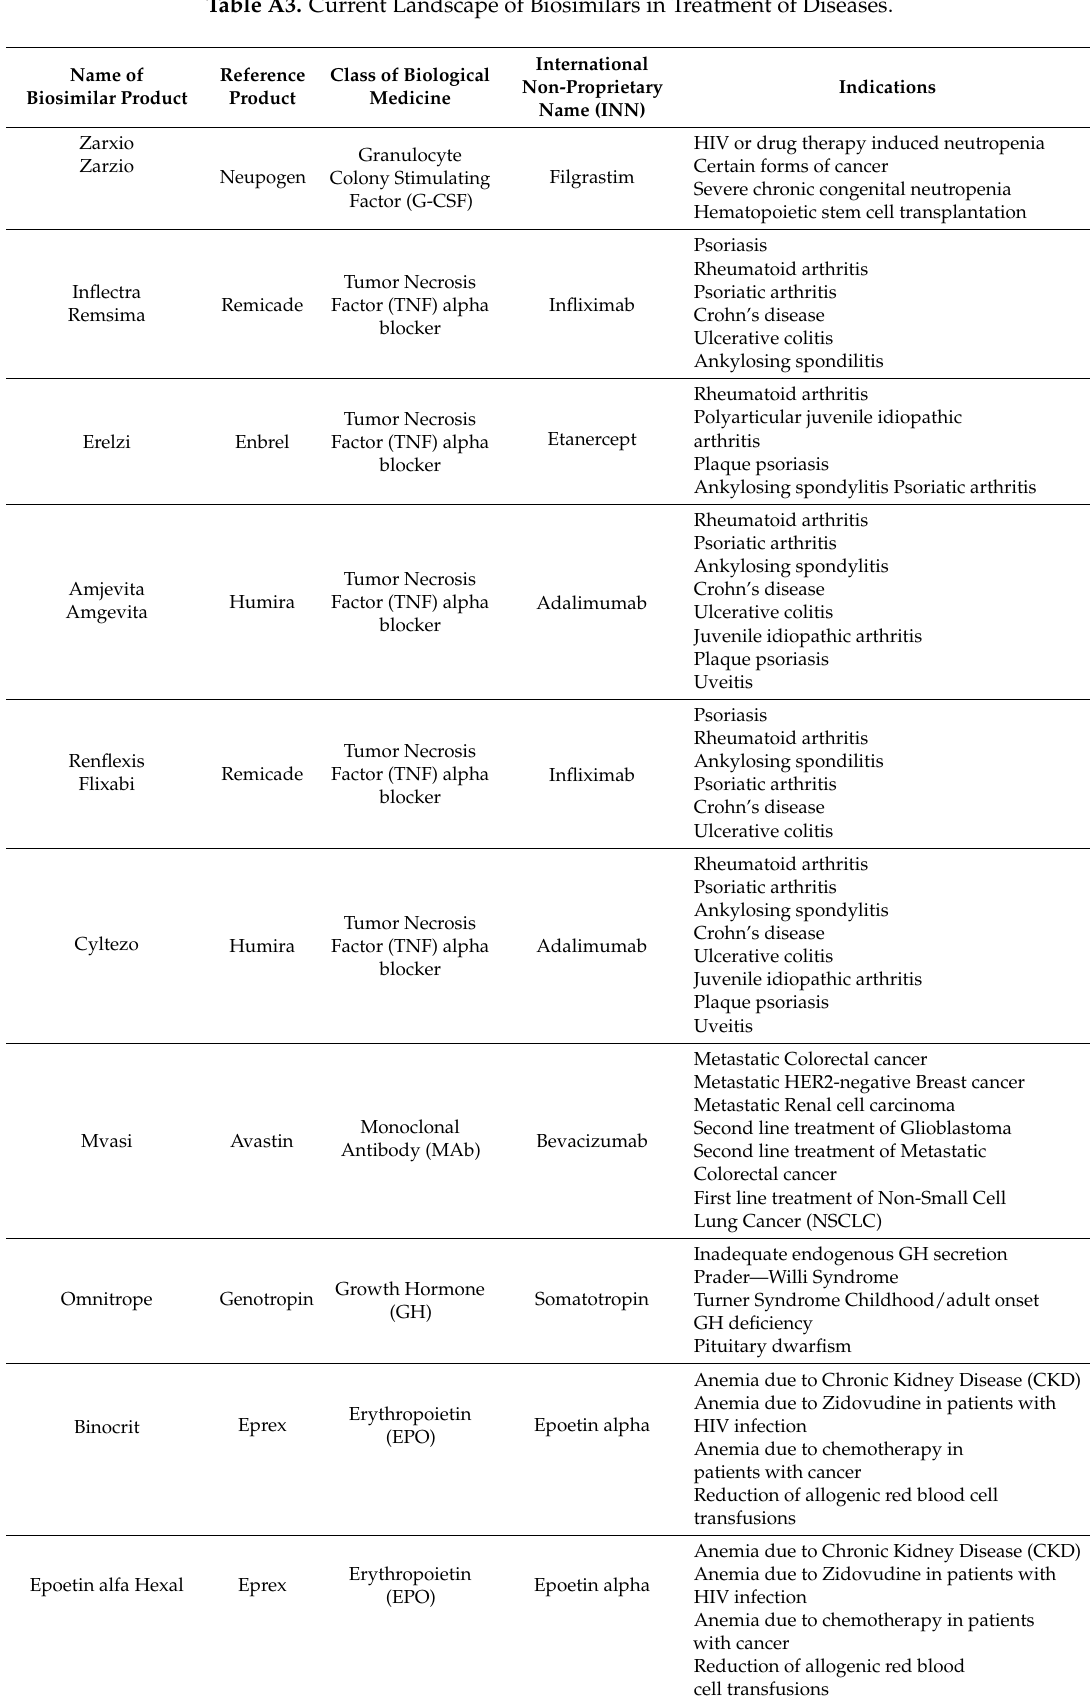
Table A3. Current Landscape of Biosimilars in Treatment of